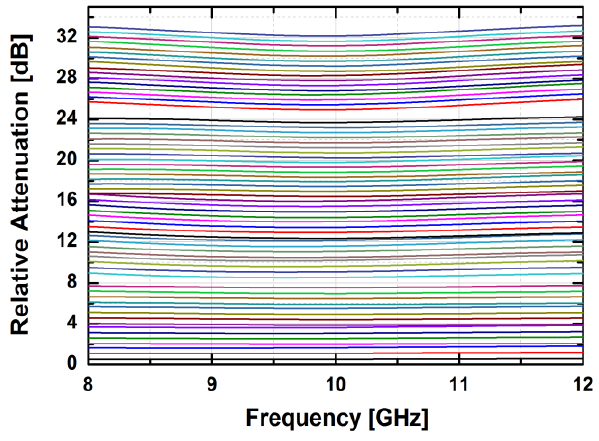
Figure 26. The relative attenuation levels of the TRM vs. the control bits over frequency.